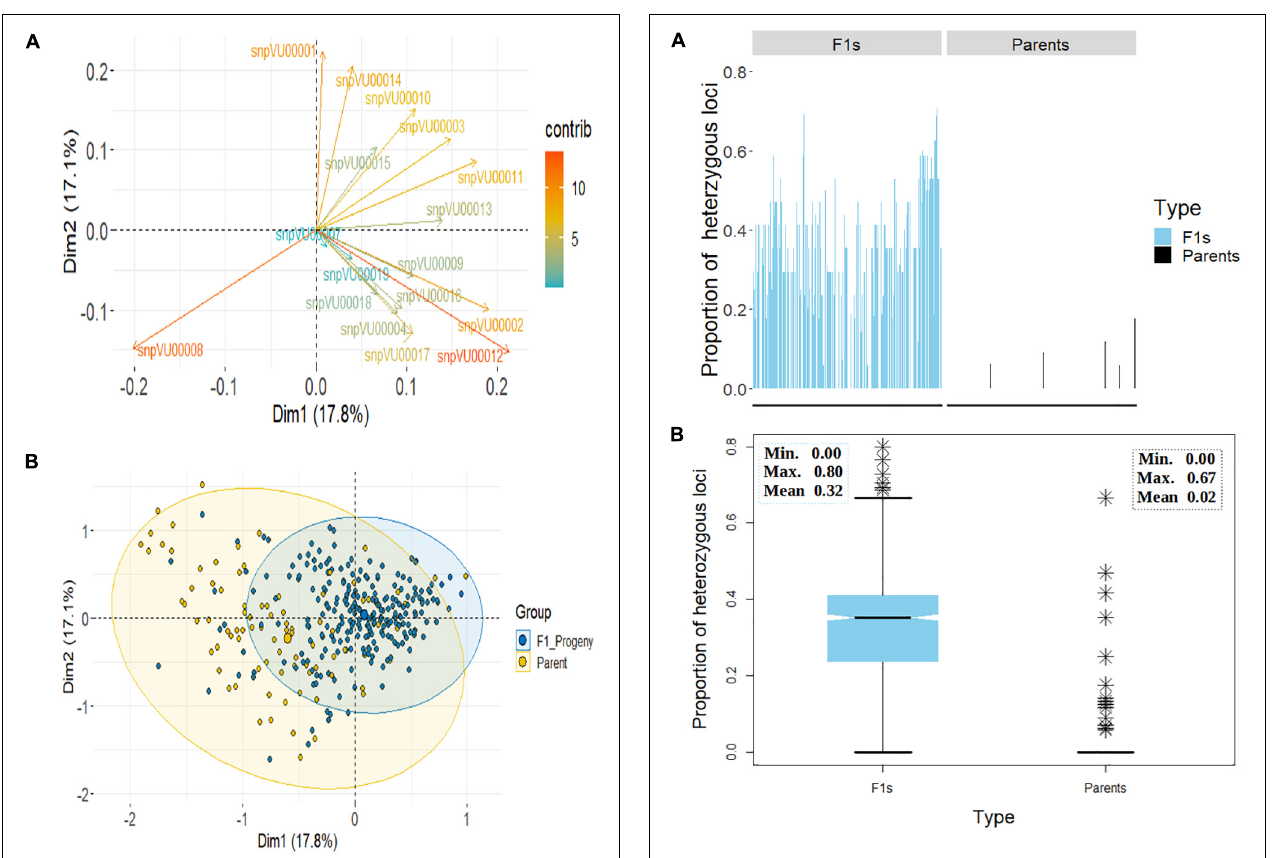
FIGURE 6 | Principal component analysis (PCA) of F 1 and the parents. (A) Contribution of each KAP-based single nucleotide polymorphism (SNP) markers to variation among genotypes; color scale on the right side indicates level of contribution. (B) PCA scatter highlighting the F 1 progenies and the parents.